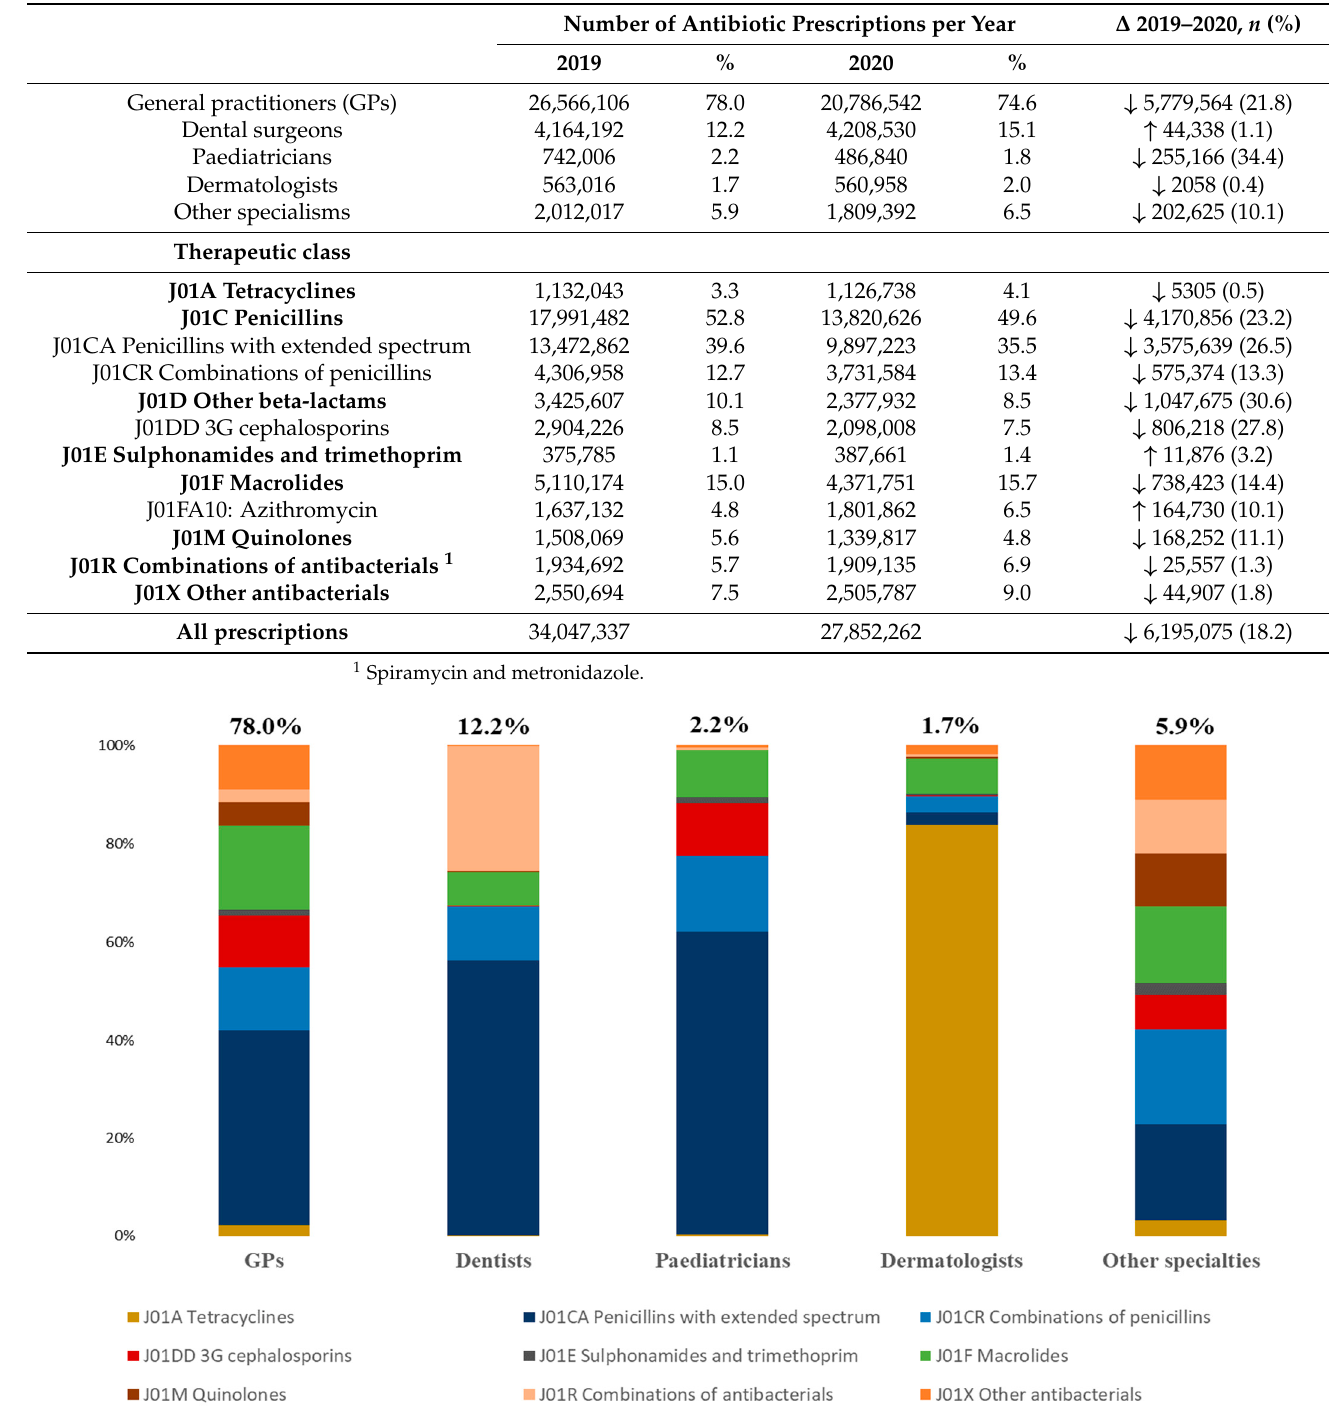
Figure 2. Distribution of therapeutic classes of antibiotics prescribed according to subspecialty of prescriber, 2019,